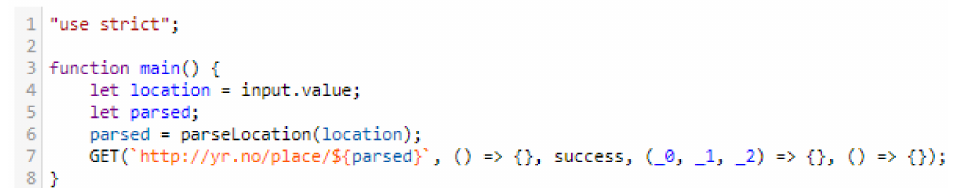
Figure 5. The main function of the source code generated by the platform from the steps presented in Figures 3 and